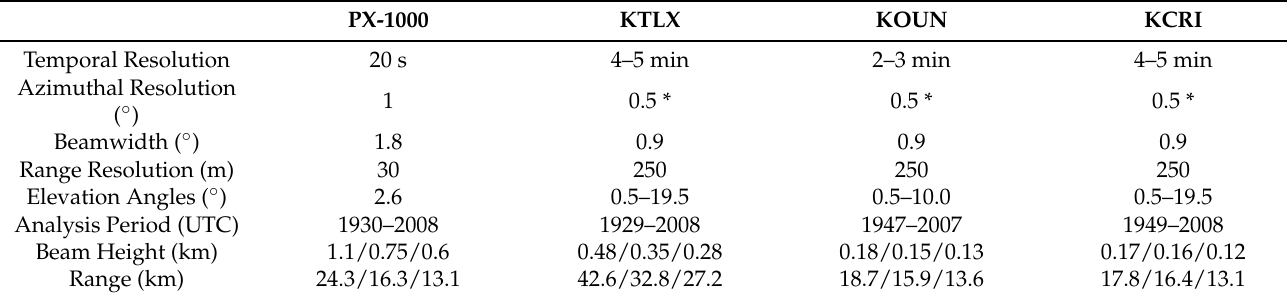
Table 1. Radar and analysis specifications for PX-1000, KTLX, KOUN, and KCRI on 20 May 2013. The radar specifications consist of temporal, azimuthal, and range resolution, as well as beamwidth, and elevation angles. Asterisks denote the azimuthal resolution for the lowest three elevations; above the third elevation, azimuthal resolution is 1 ◦ . The analysis specifications consist of the respective analysis periods as well as beam height at and range to the low-level mesocyclone (LLM) for the lowest scanning elevation at the start of the analysis period/tornadogenesis ( ∼ 1956 UTC)/end of the analysis